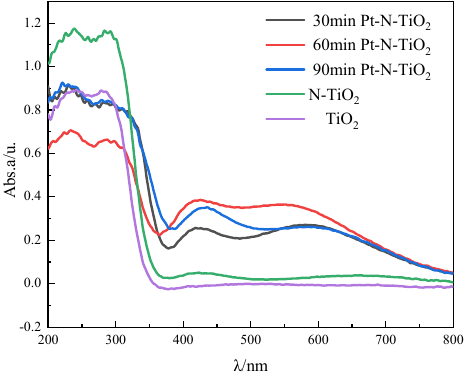
Figure 4. UV − VIS − DRS pattern of each nanotube.